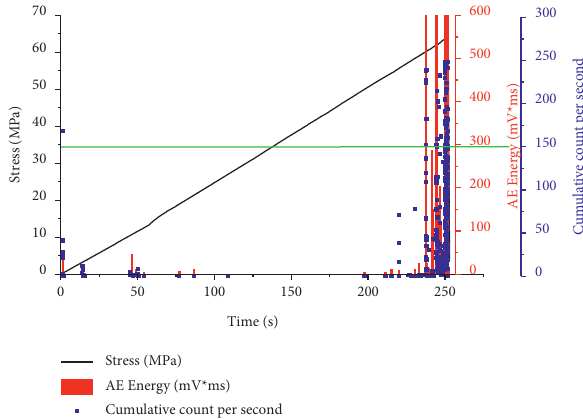
Figure 7: Characteristic map of early warning value of loaded rock.